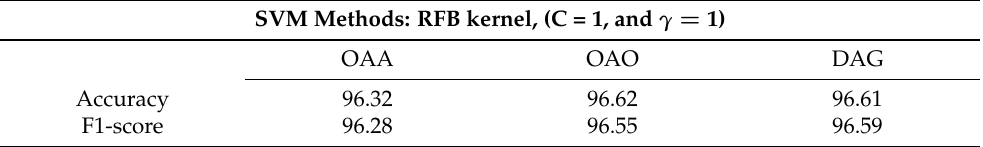
Table 2. Comparing various SVMs multiclass